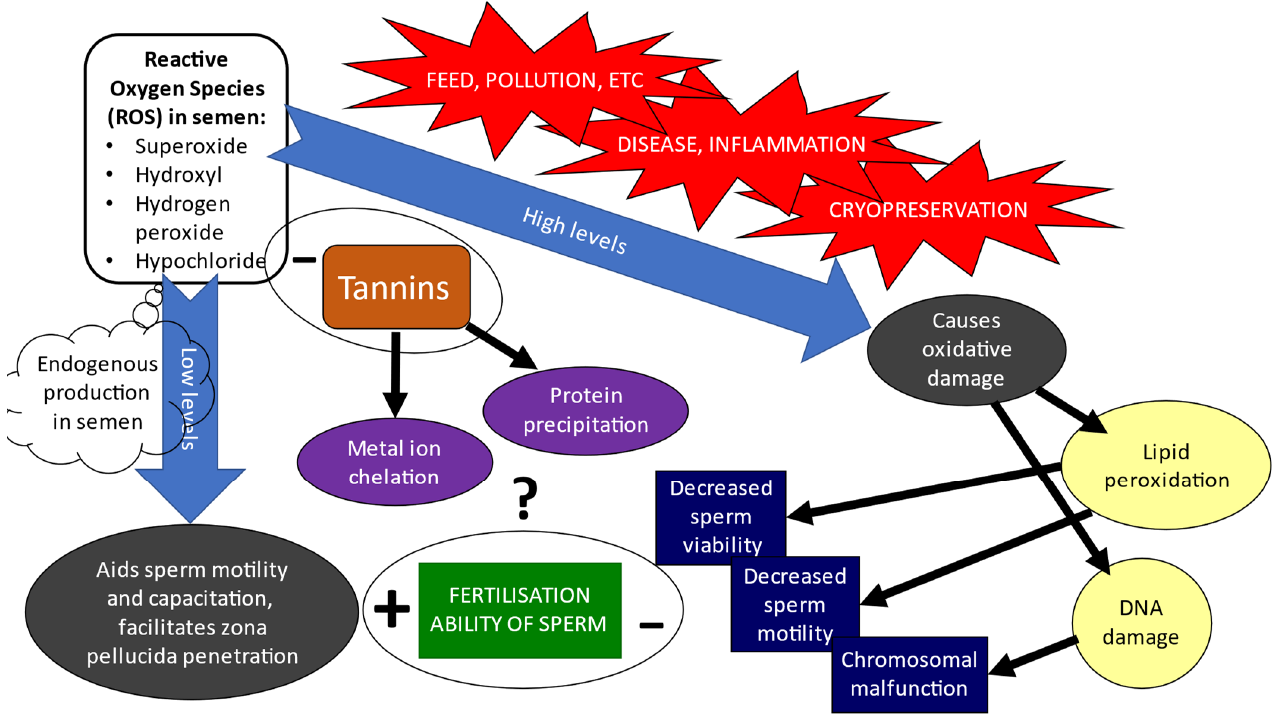
Figure 2. Demonstration of the homeostatic effects of ROS on sperm’s fertilisation ability, and the potential benefits of tannins to ameliorate its effects, particularly following cryopreservation.